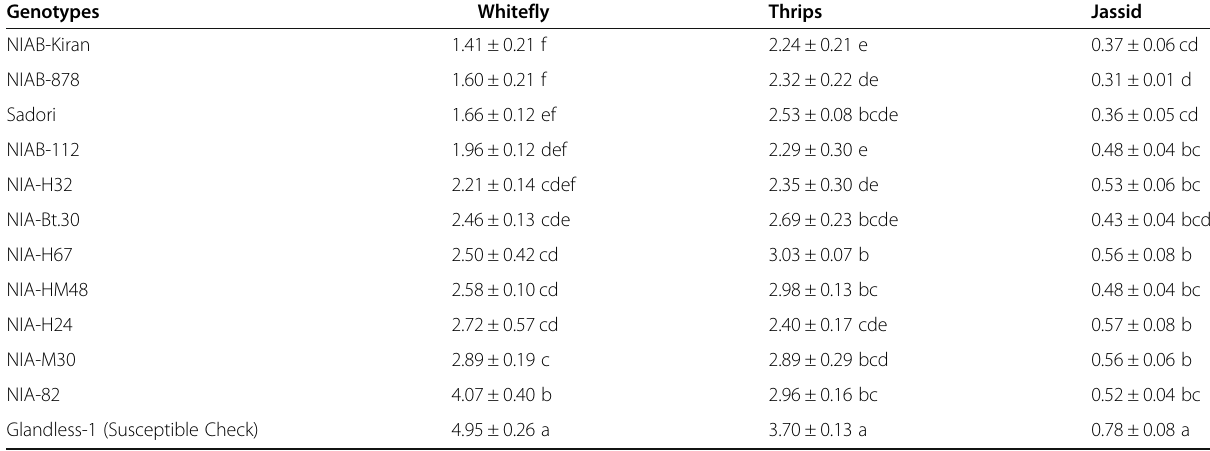
Table 1 Mean population of sucking insect pests (number/leaf) on different genotypes of cotton